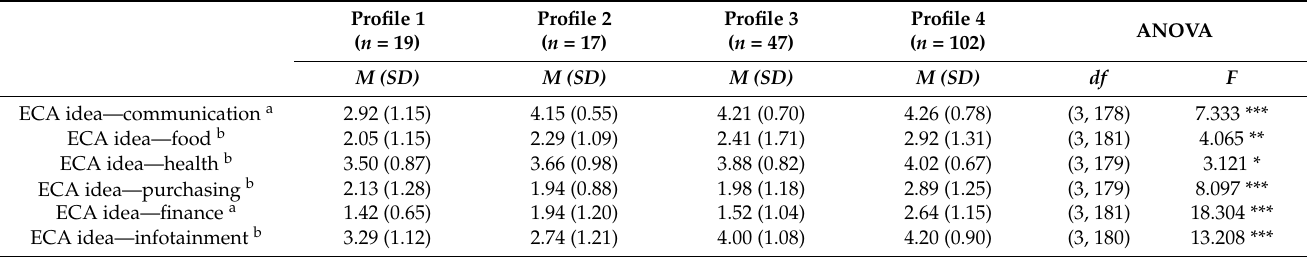
Table 3. Differences between profiles regarding the acceptability of ECAs in different IADL